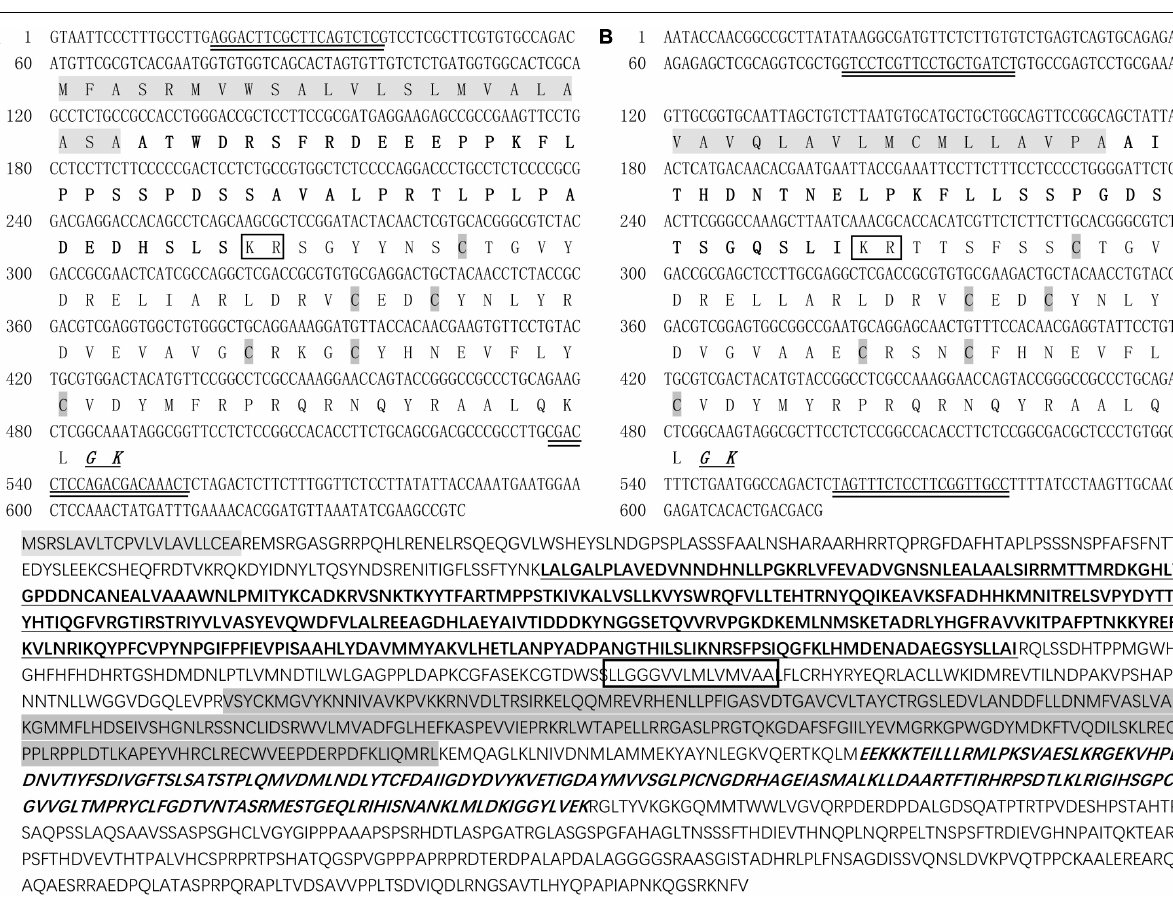
study whether LvCHHs could regulate the expression of LvIAG